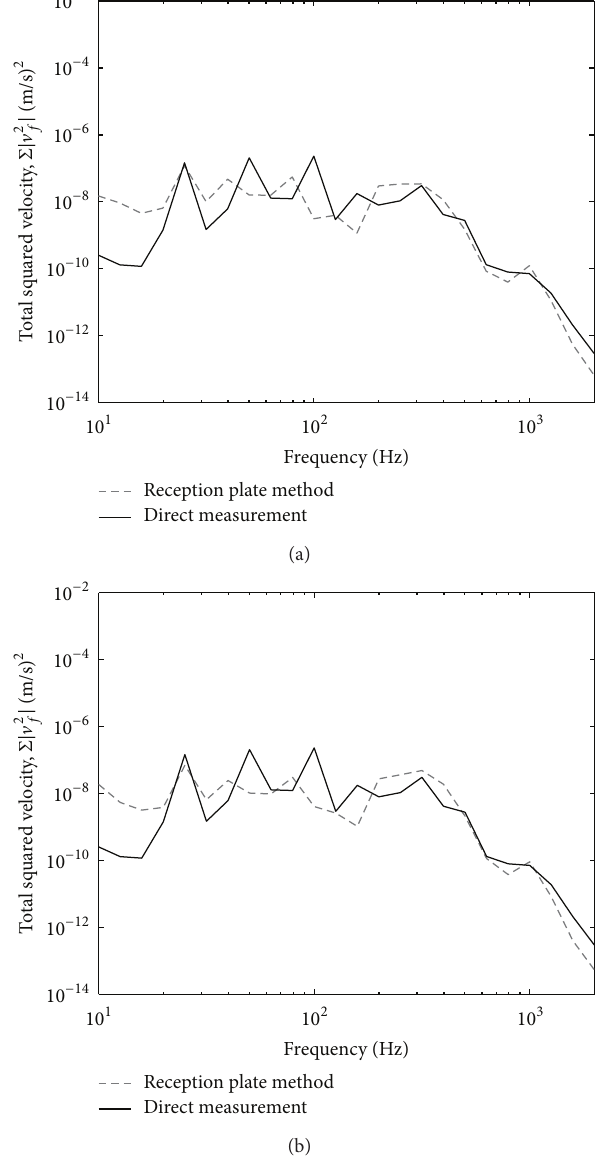
Figure 9: Comparison of the squared free velocity obtained from the reception plate method (thick line) and direct measurement (thin line): (a) zero phase and (b) random